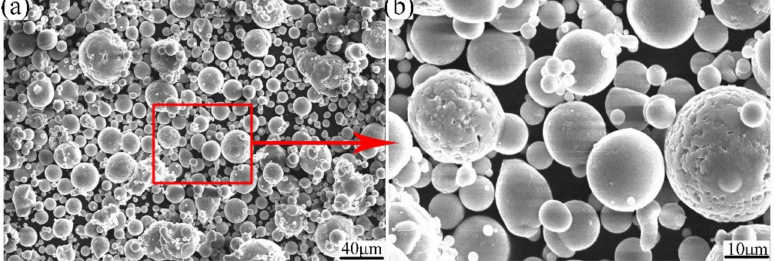
Figure 6. SEM image ( a ) and particle size distribution ( b ) of atomised Al-based alloy